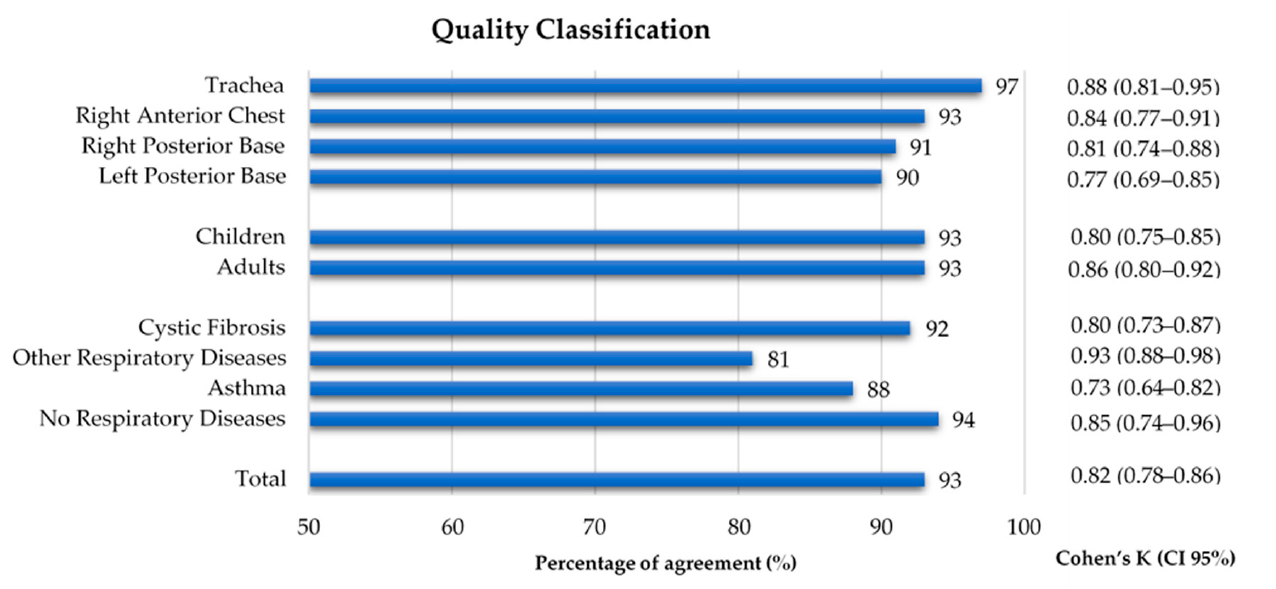
Figure 4. Percentage of agreement and inter-rater agreement on the quality classification of lung sound recordings by location, age group and diagnostic group.